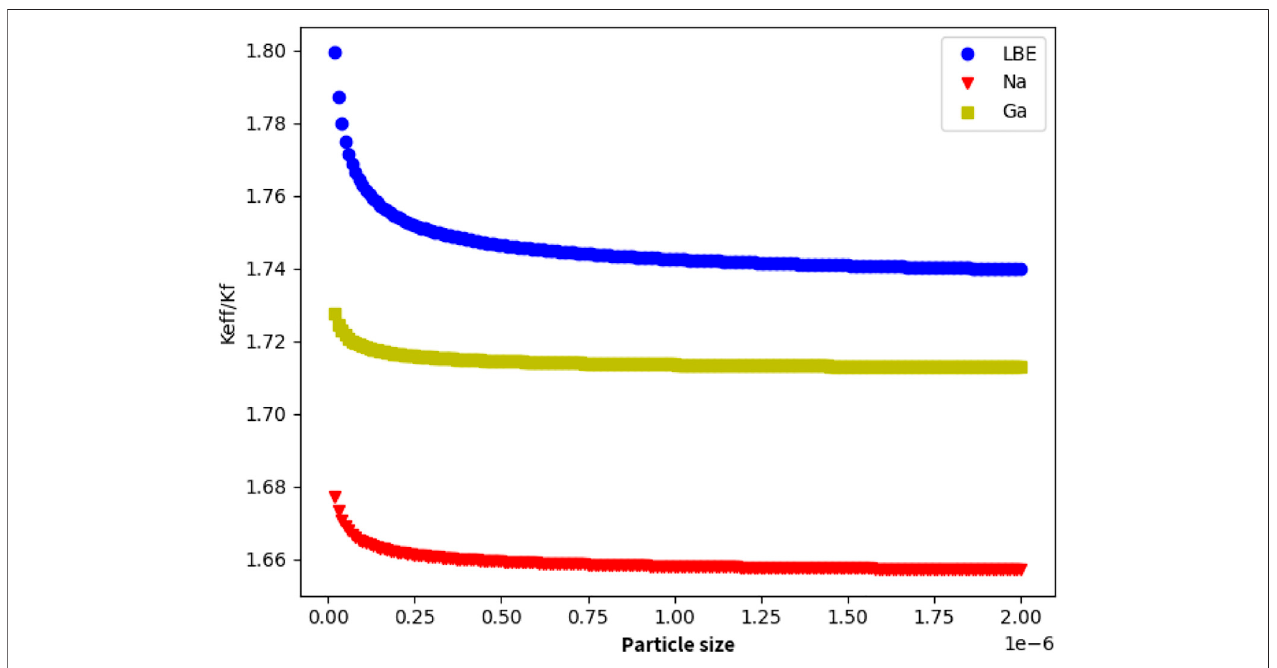
FIGURE 6 | Thermal conductivity change with particle size (T (cid:2) 600 K, φ (cid:2) 0.2).